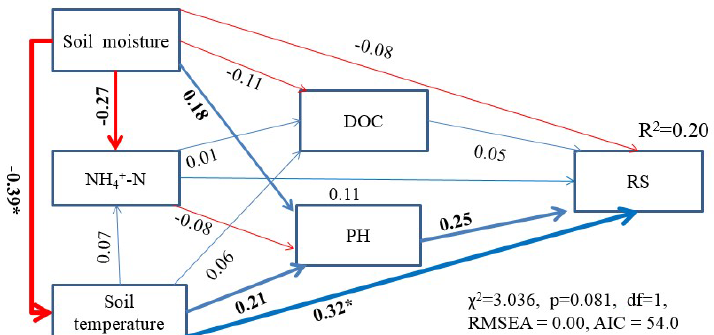
Figure 5. Structure equation model (SEM) testing the multivariate (soil moisture, soil temperature, soil NH + effects on R s ( n = 34). Arrows show the effects of different key controls on R s analyzed. The blue arrows indicated positive effects, and red arrows showed negative effects. The width of the arrows indicate the strength of the relationship. The numbers are standardized path coefficients, which can show the importance of the variables in the model. Goodness-of-fit statistics for the model are shown below the model. Asterisks indicate significant effect at P